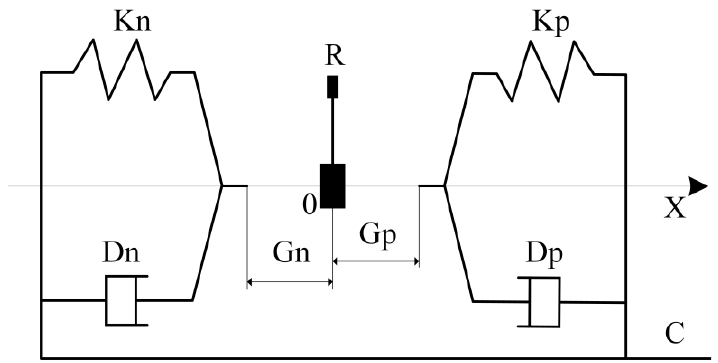
Figure 3. Collision model. Figure 3. Collision